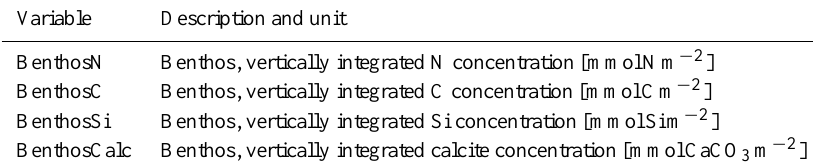
Table A2. State variables; benthos.